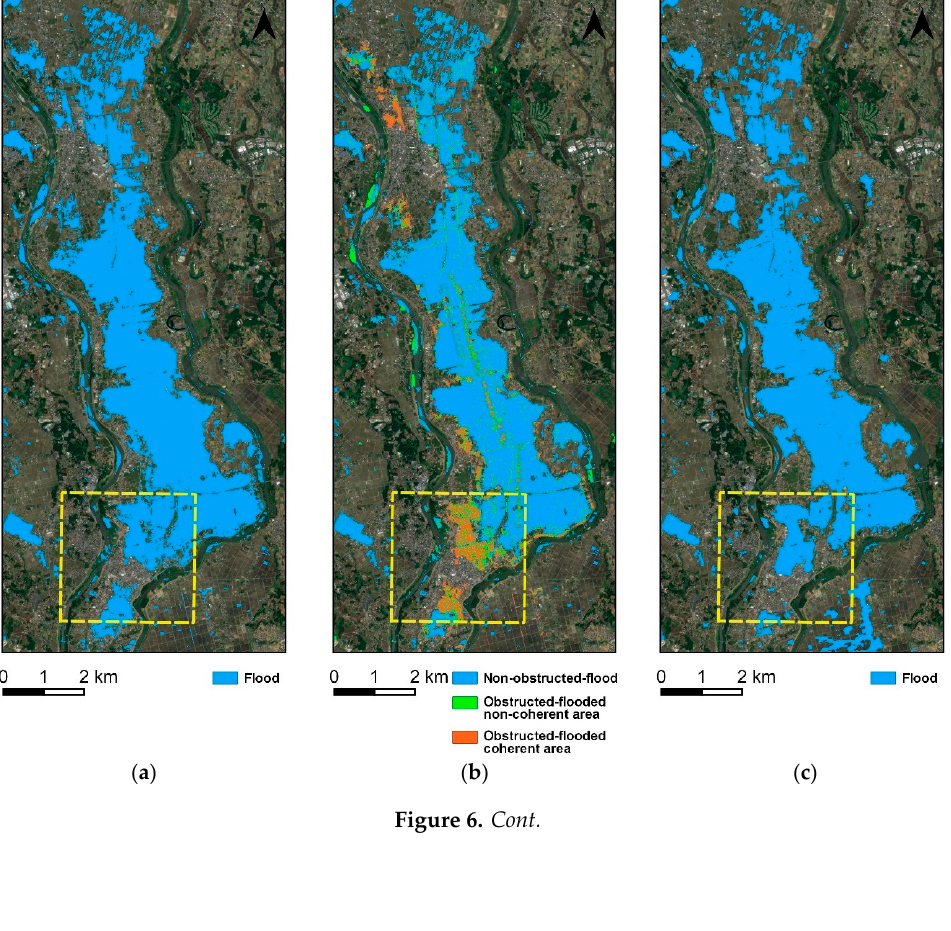
Table 6. Quantitative evaluation of the Joso flood case (FPR: false-positive rate, OA: overall accuracy).